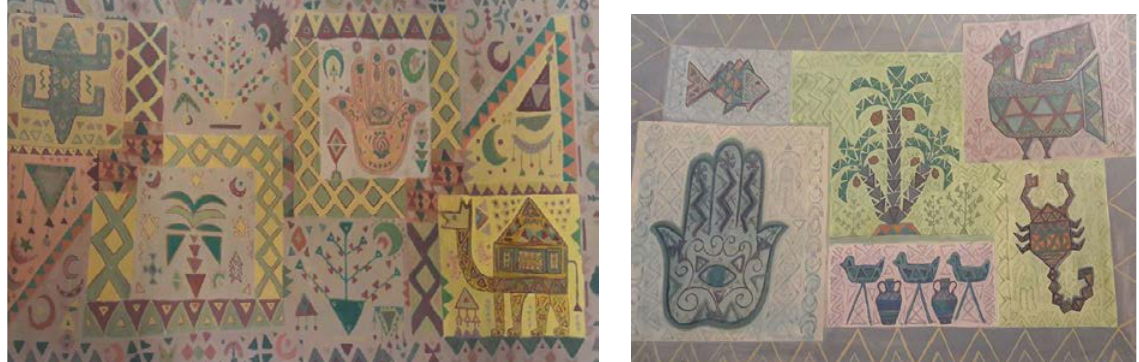
Figure (1): Example of Prof. Ahmed Hosni Folklore Artwork. Source: Prof. Ahmed Hosni Photos Album Library .